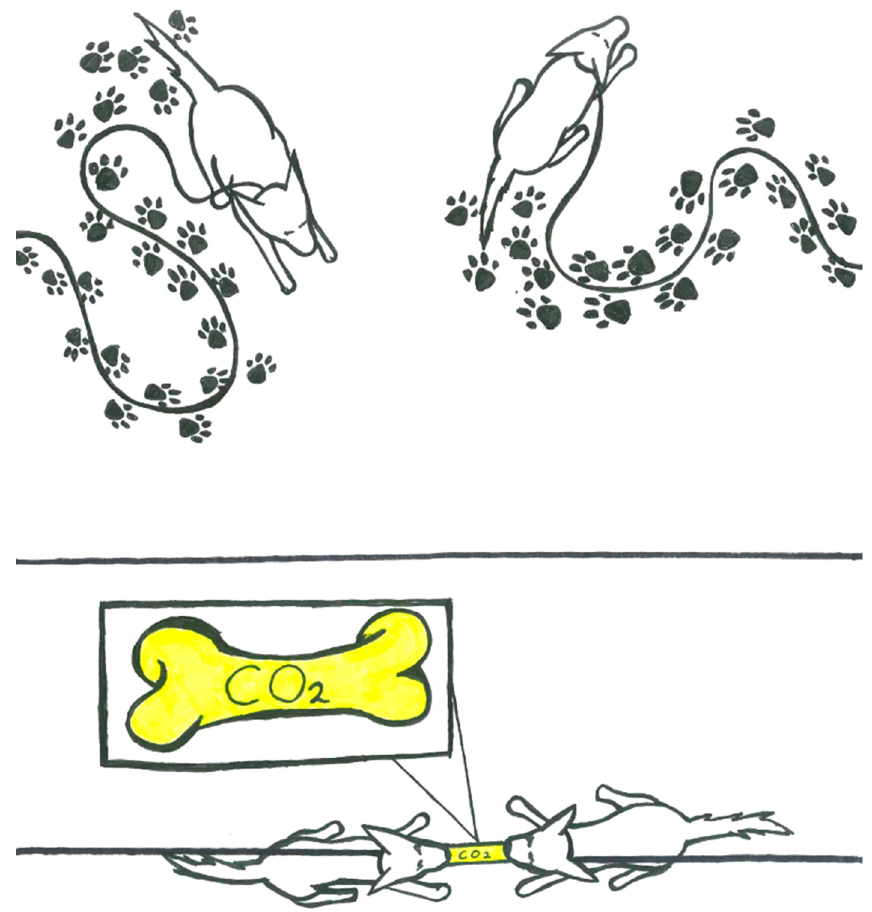
Figure 8. The genius of the rubisco-capture system stems from the large reduction of system entropy associated with bringing the two tethered capture moieties (the Mg 2+ site and the lysine amino group) together on CO 2 capture. The principle is well exemplified by the image of two leashed dogs biting on the same bone. In the absence of the bone, each dog enjoys great freedom in their accessible range ( illustration on top ). Biting on the same bone curtails the accessible range and the freedom of the dogs’ mobilities ( bottom ).